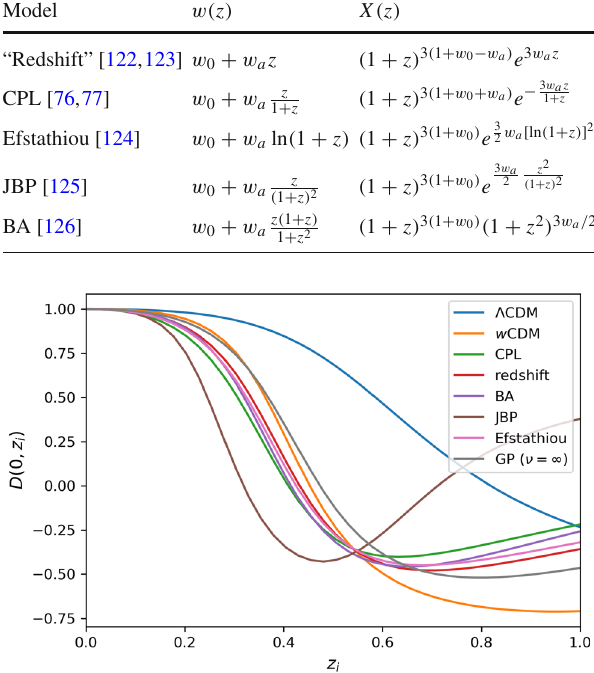
Table 4 DDE parametrisations/models Model